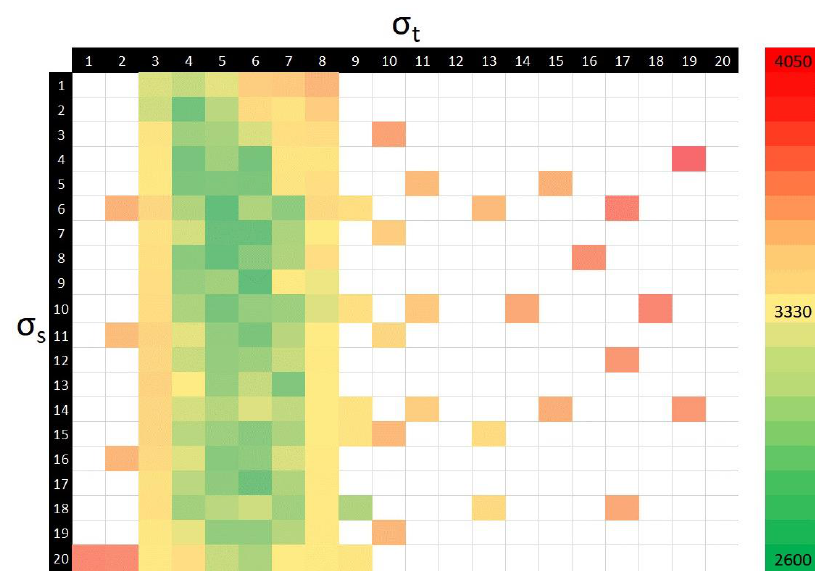
Figure 8. Heatmap showcasing the average error rate for different combinations of for σ s and σ t (lower is better).